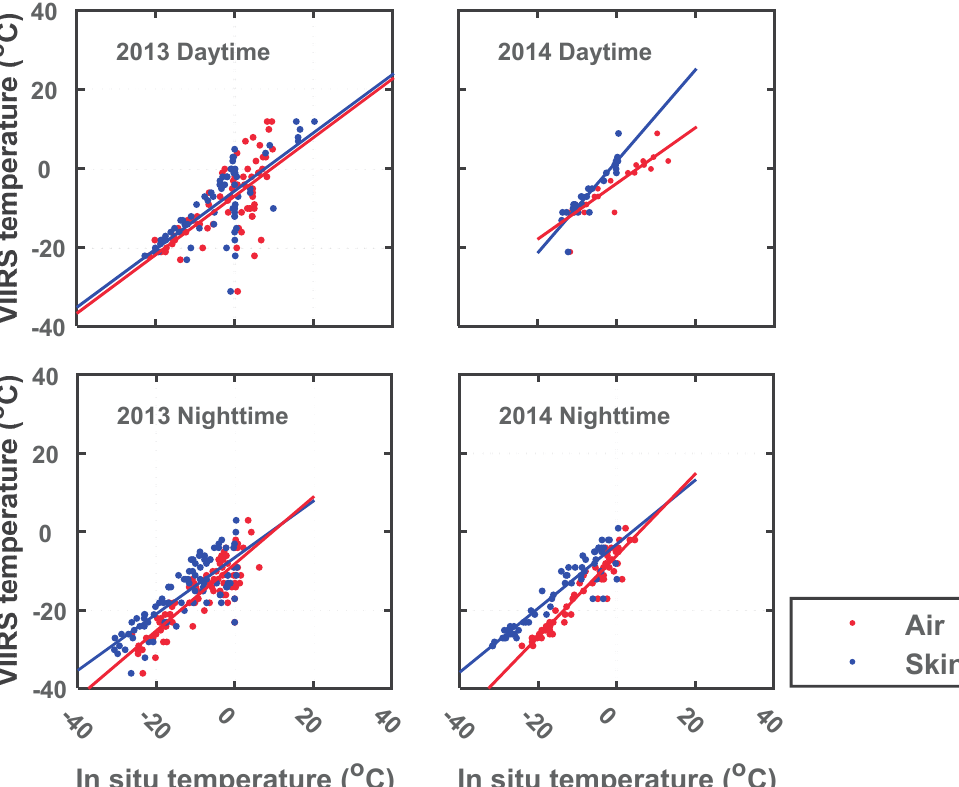
Figure 7 . CREST-SAFE in situ T-skin and T-air vs. satellite VIIRS LST daytime and nighttime data for the bare land pixel scatterplots for winters 2013 and